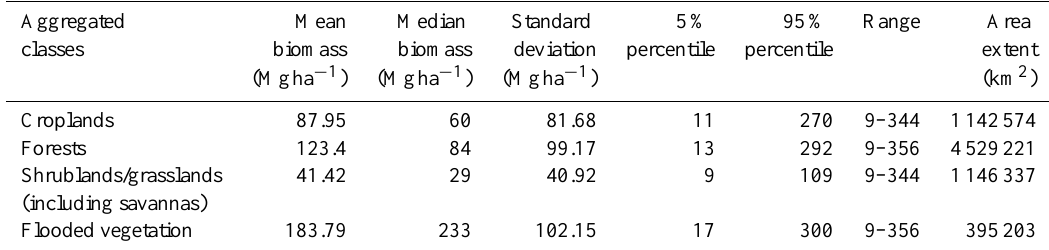
Table 4. Biomass values and extent according to aggregated GlobCover 2009 land cover